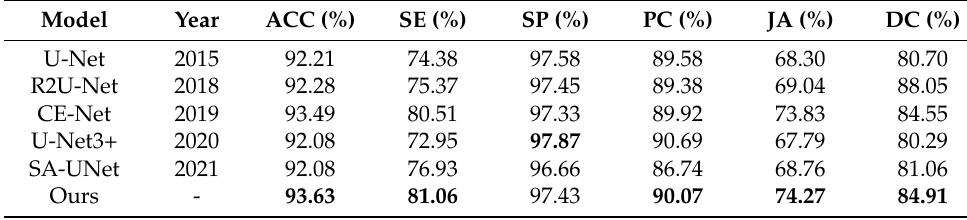
Table 5. Evaluation indicators of each comparative network on